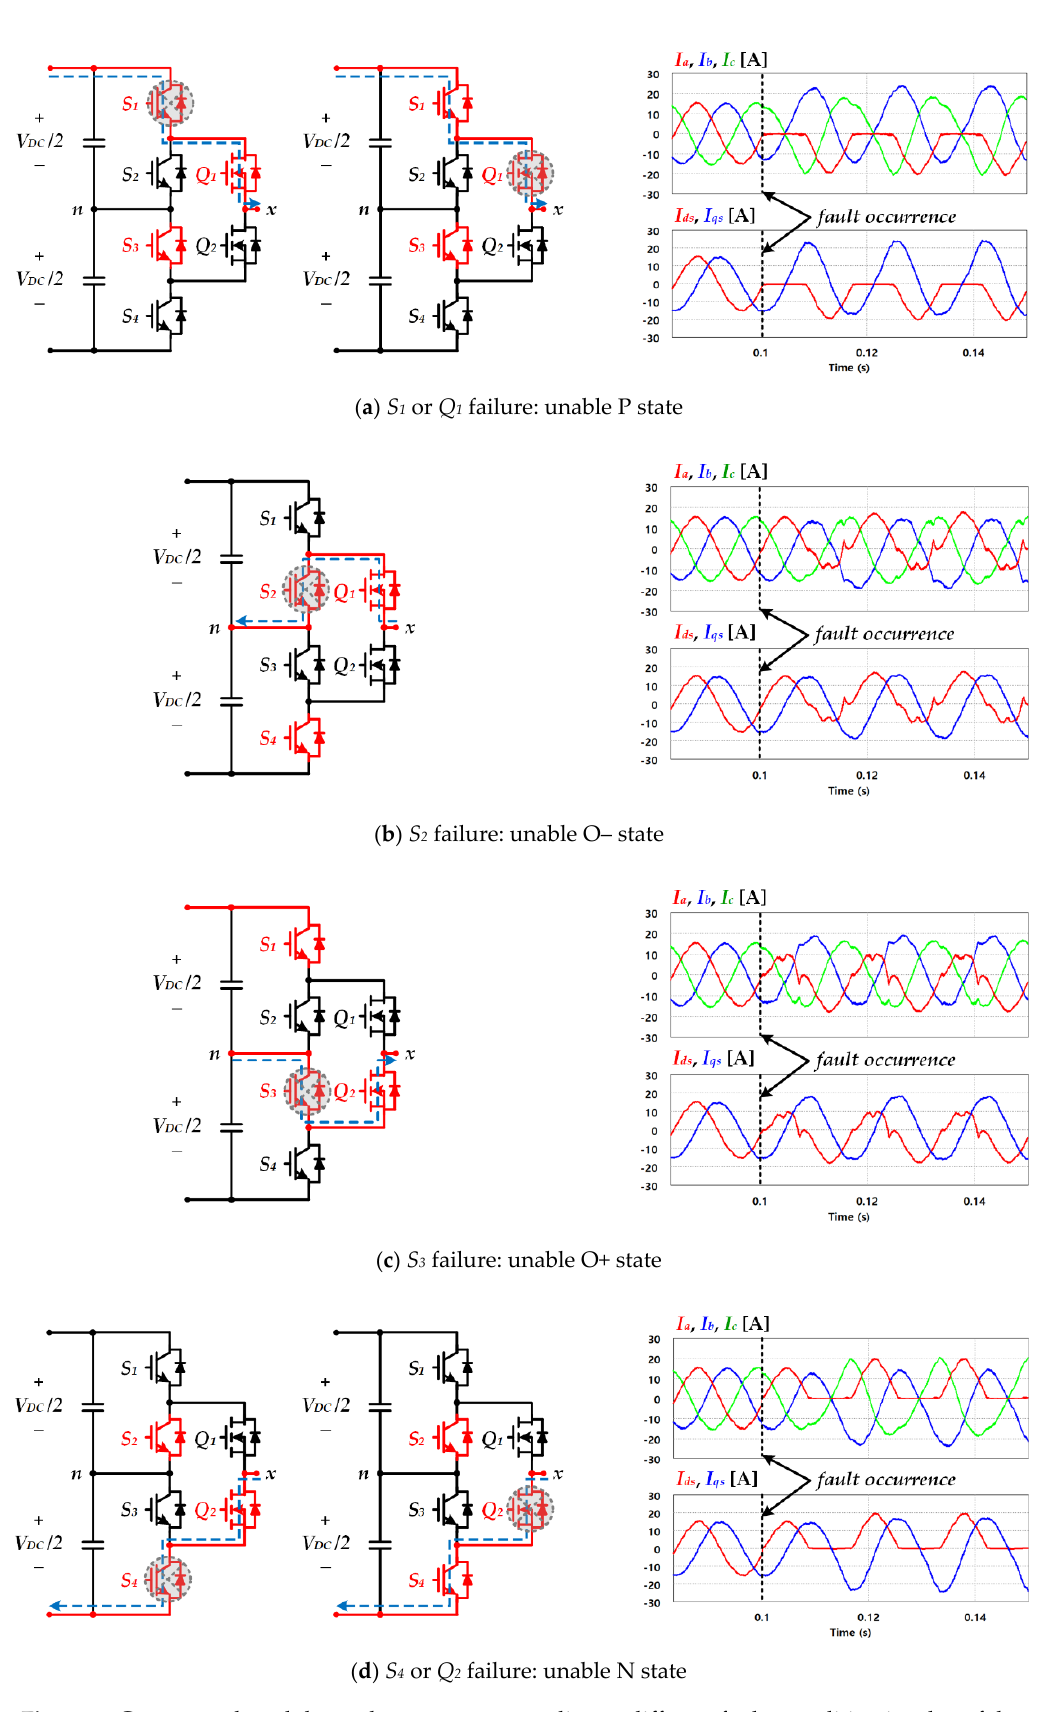
Figure 6. Current path and three-phase current according to different faulty condition in a leg of the HANPC inverter.